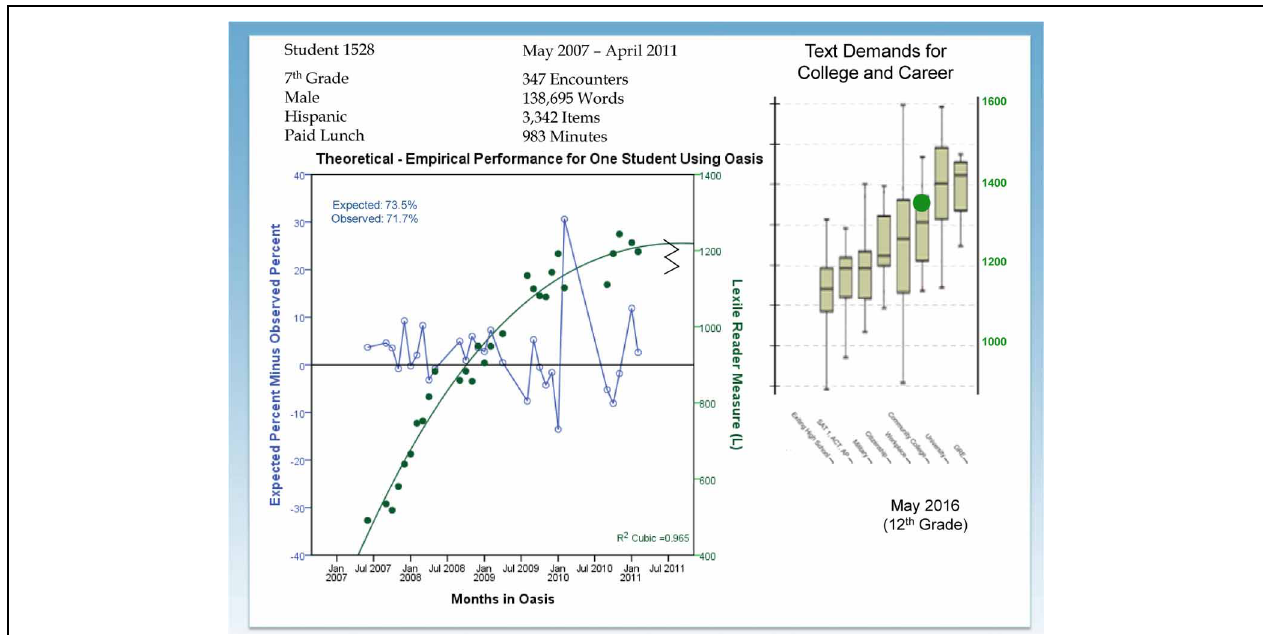
FIGURE 1 | Growth in reading ability relative to the reading demands of adulthood.